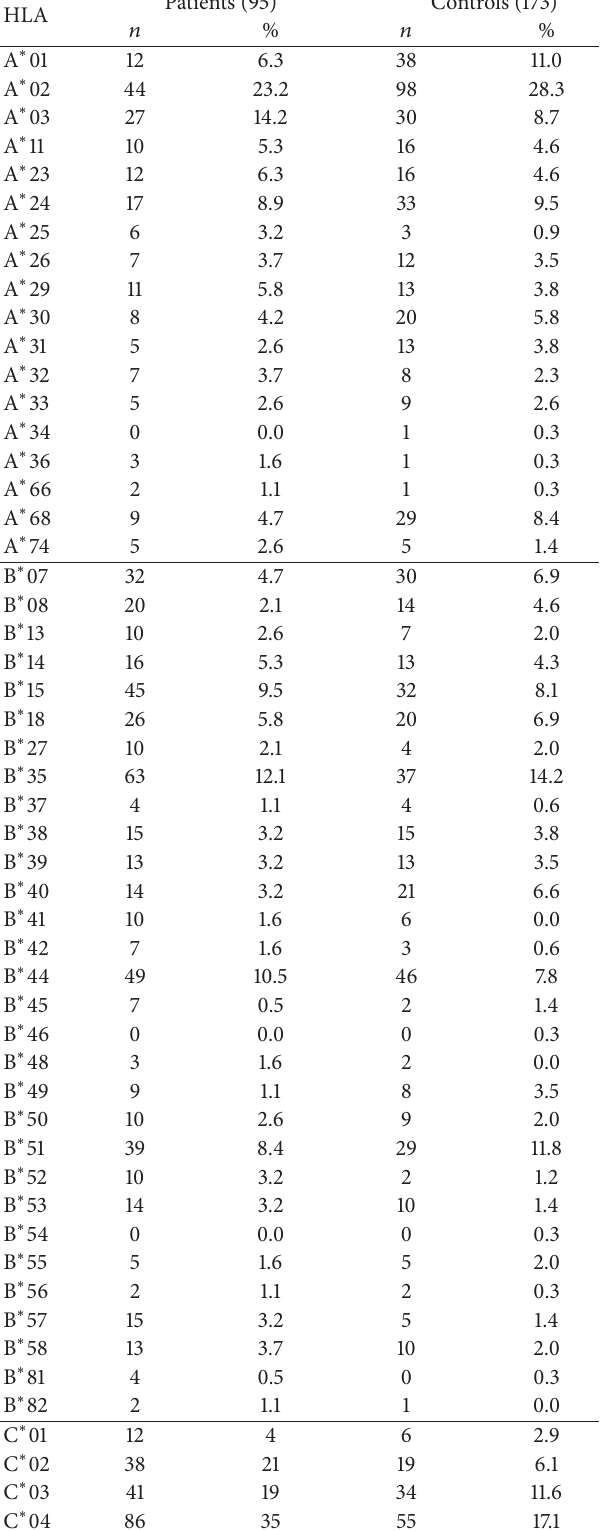
Table 1: Comparison of the frequencies of class I HLA alleles between the control group and patients with clinical-serologic diagnoses of dengue infection in the South of Brazil, occurring in 2007 during a serotype 3 virus